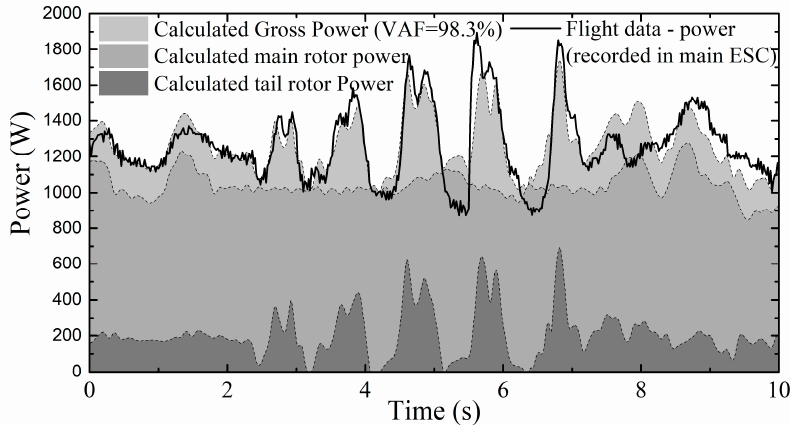
Figure 10. Power dissipation comparisons during the yaw maneuver in hover.